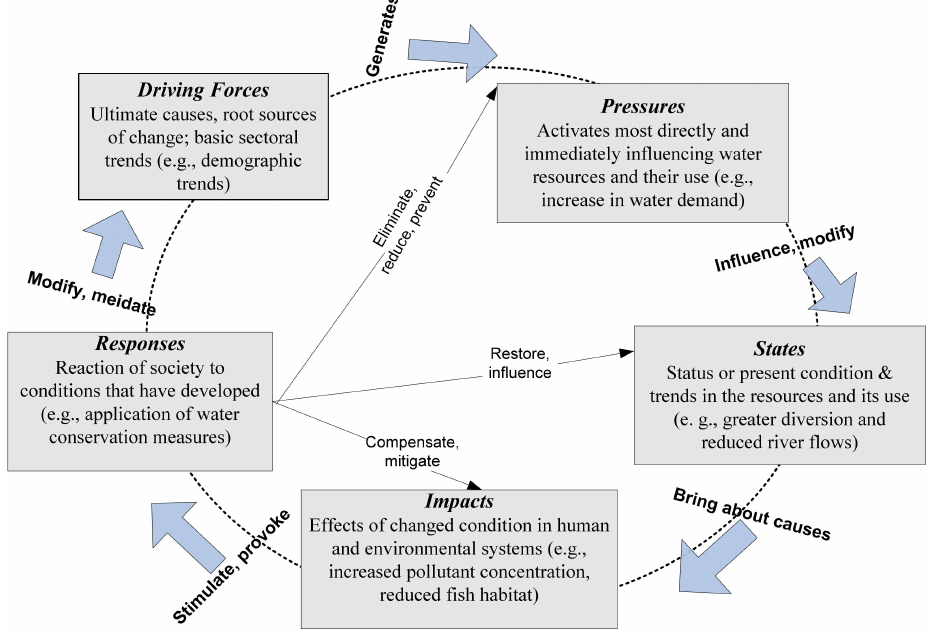
Figure 3. DPSIR framework with an application example (modified from Khatri